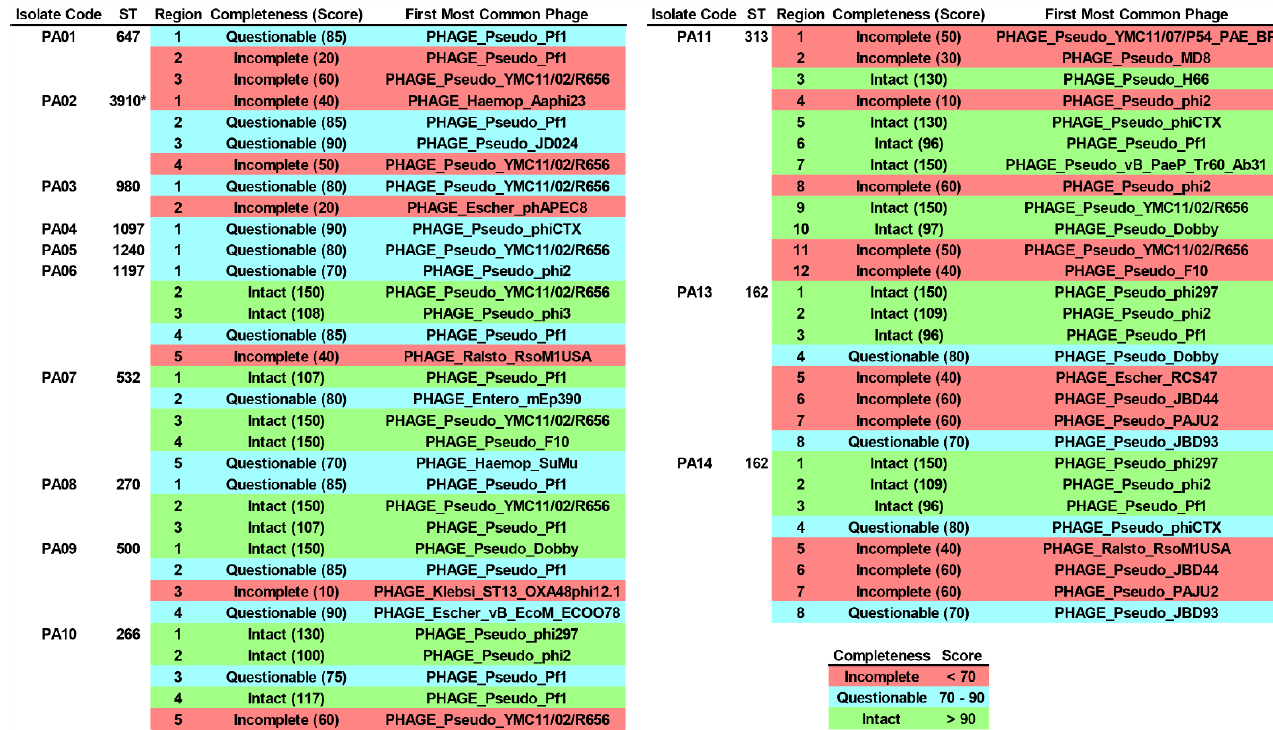
Figure 5. Integrated bacteriophage genomes (IBGs) in the colonizing isolates of P. aeruginosa . ST, sequence type. * Novel ST.